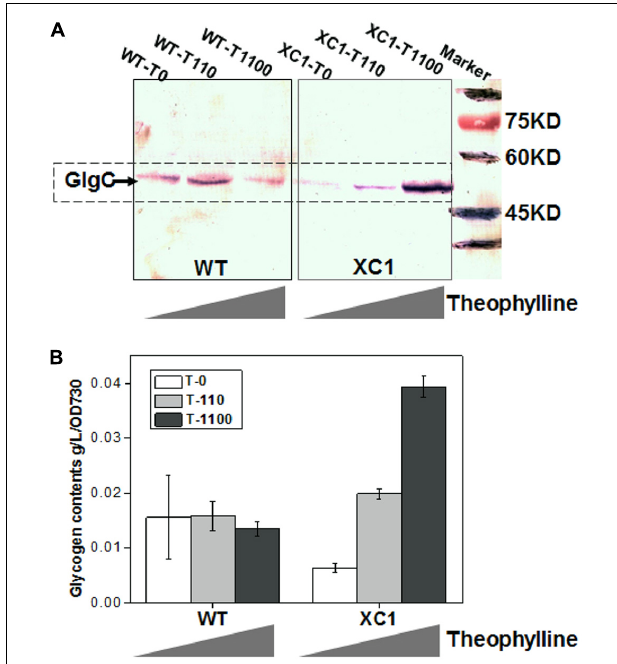
FIGURE 2 | Theophylline-dose regulated GlgC abundances and glycogen storage in PCC7942-XC1. (A) Western blot assay for GlgC concentrations in WT strain and XC1 strain under serial theophylline concentrations (T0, no theophylline addition; T110, 110 µ M theophylline; T1100, 1100 µ M theophylline). In PCC7942, glgC gene encodes a protein with MW of about 48 kDa, consistent with the band locations marked in the PVDF membrane. (B) Glycogen contents in WT strain and XC1 strain under serial theophylline concentrations. The data shown are averages of at least three independent biological repeats, and standard deviation bars are also